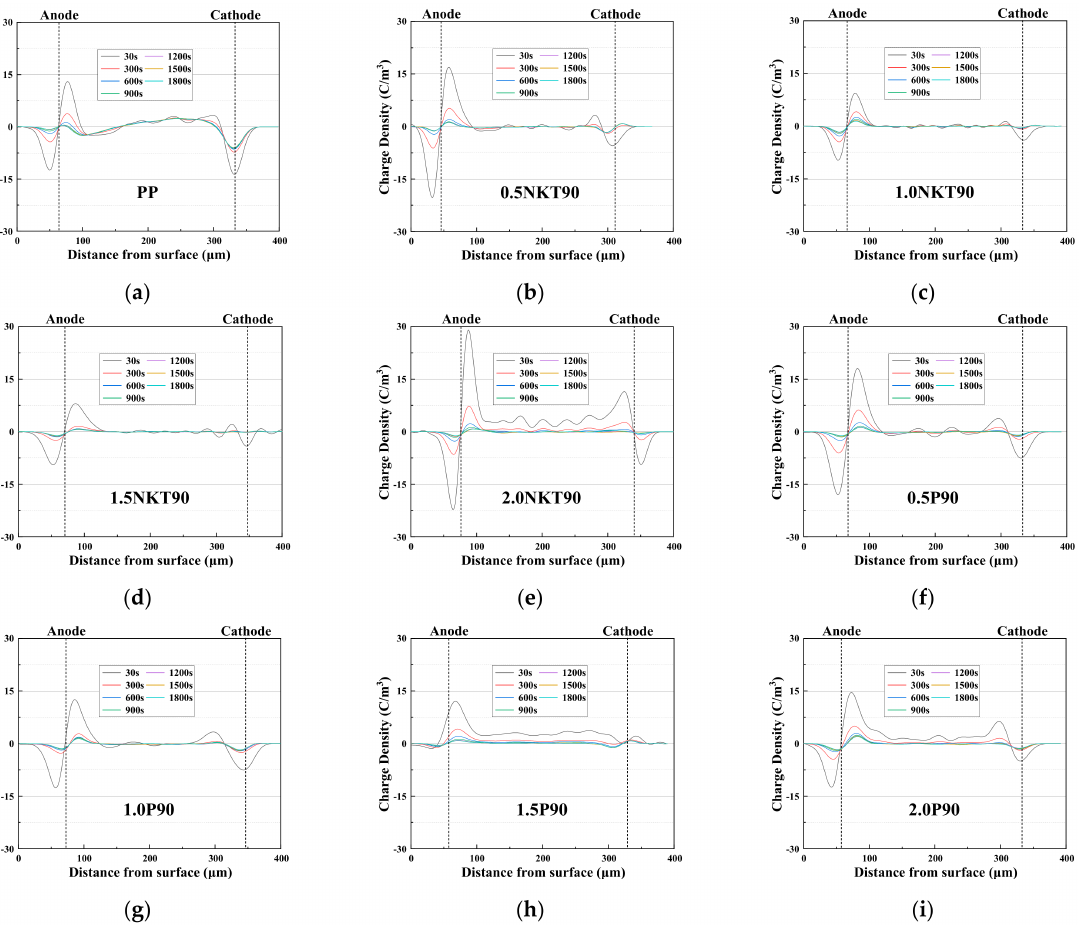
Figure 6. Charge distribution in the depolarization stage of nanocomposites. ( a ) PP; ( b ) 0.5NKT90; ( c ) 1.0NKT90; ( d ) 1.5NKT90; ( e ) 2.0NKT90; ( f ) 0.5P90; ( g ) 1.0P90; ( h ) 1.5P90; ( i )